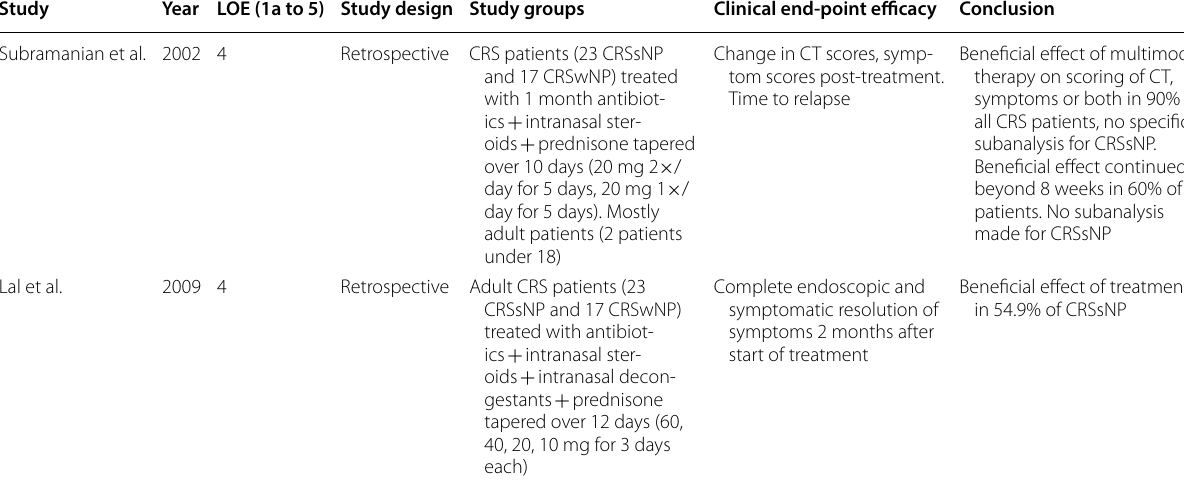
CRS chronic rhinosinusitis, CRSsNP chronic rhinosinusitis without nasal polyps, CRSwNP chronic rhinosinusitis with nasal polyps